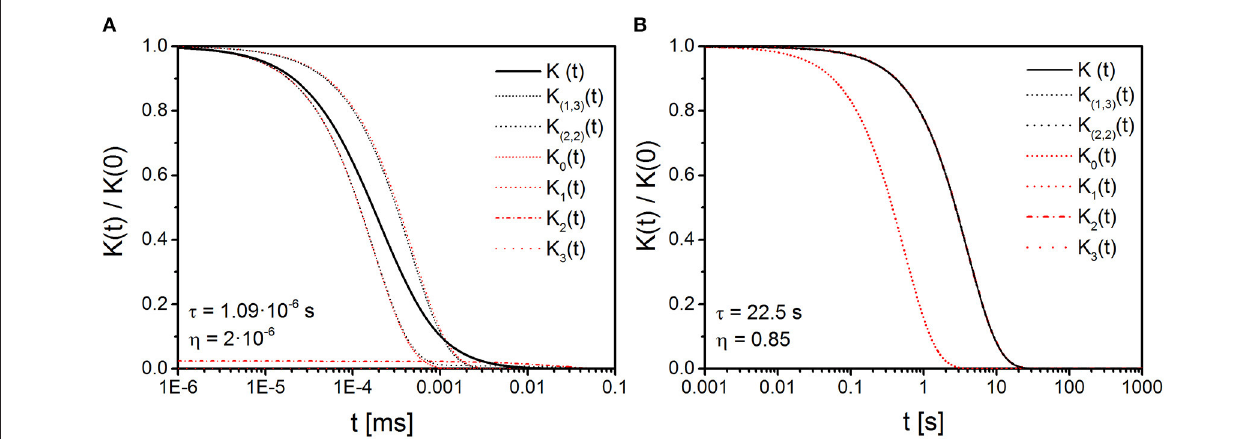
FIGURE 6 | Mono- and bi-exponential approximation in the GMA for nanoparticles and lung tissue. (A) Mono- and bi-exponential approximations are compared to the correlation function K ( t ) [solid line, obtained from Equation (14)]; parameter set obtained from Muller et al. [ 52], see also main text. For this extremely short correlation time τ , the monoexponential approximations K 0 ( t ) and K 1 ( t ) coincide with the biexponential approximations K (2,2) ( t ) and K (1,3) ( t ), respectively. (B) Mono- and bi-exponential approximations for peripheral lung tissue, based on parameters given in Stone et al. [53] and Baete et al. [54]. In this case of a very long correlation time τ , most approximations coincide with K ( t